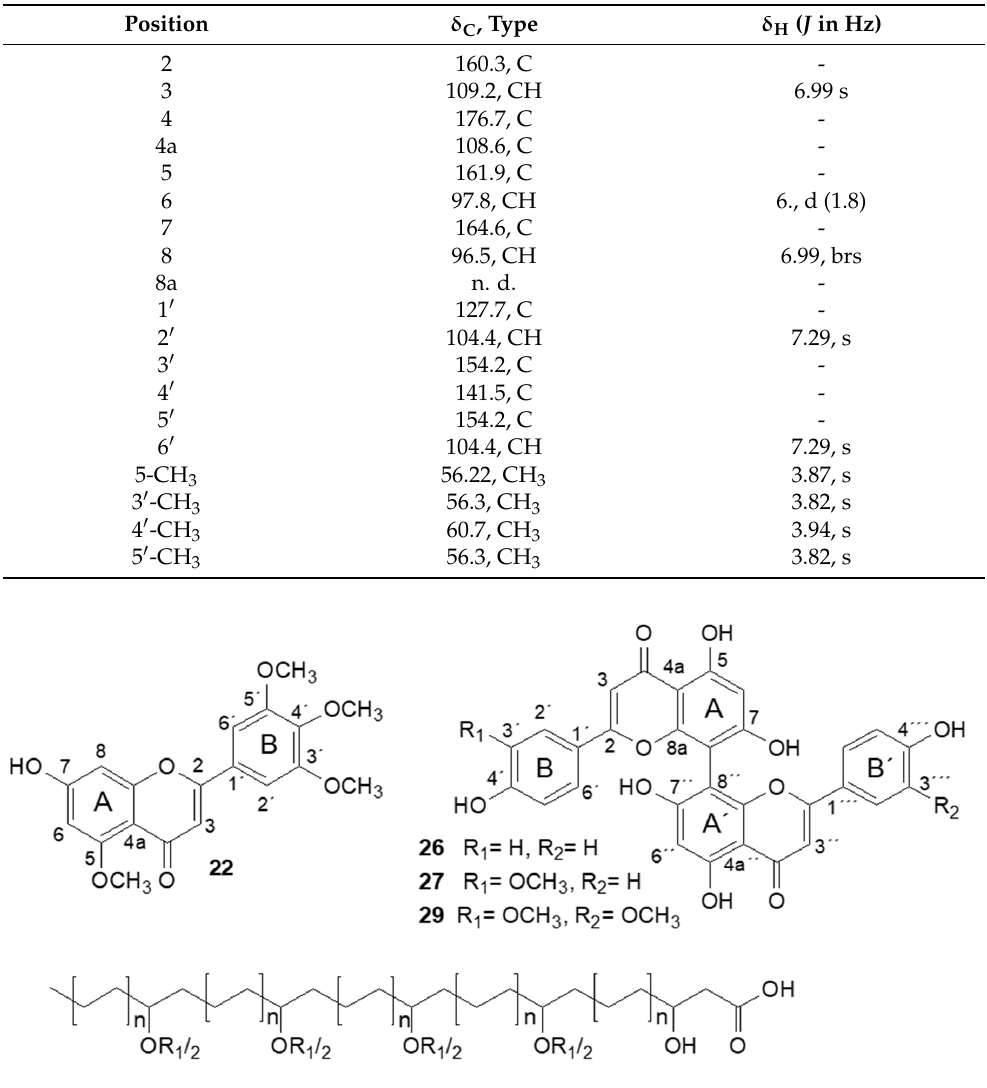
Table 3. 1 H and 13 C NMR shifts for compound 22 (pyridine-d 5 , 700 and 175 MHz, respectively); HMBC correlations, see Supplementary Figure S15.